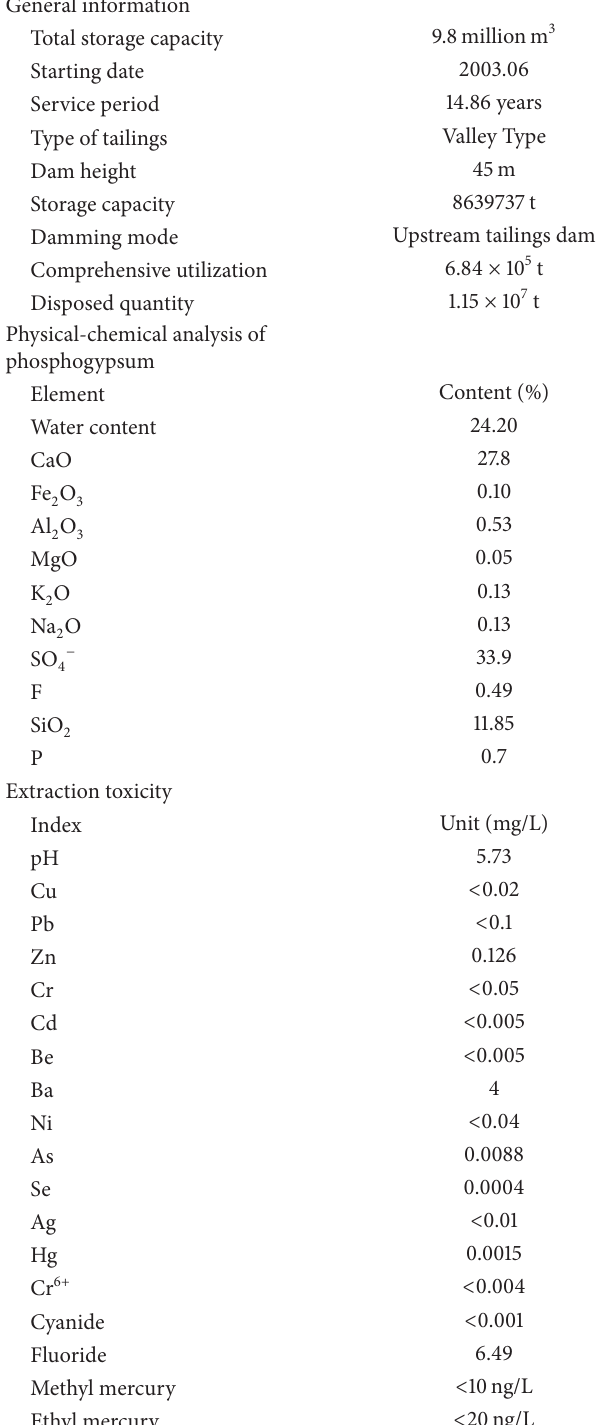
Table 3: Linguistic variables and trapezoidal fuzzy numbers for the evaluation.